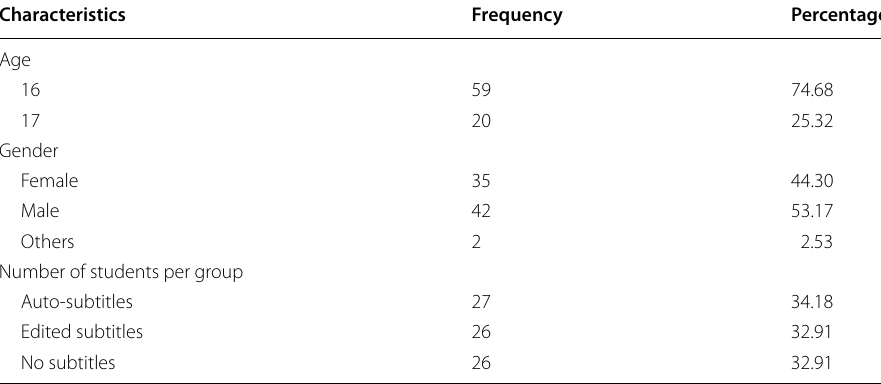
Table 2 Demographic characteristics of participants (N